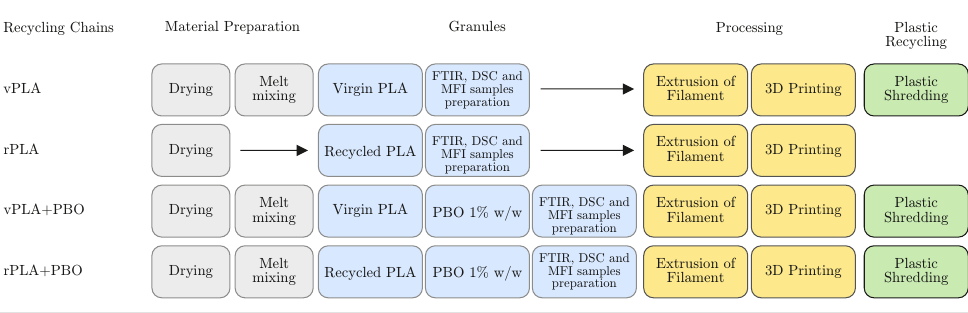
Figure 1. Description of the four different recycling chains and the processes involved (adapted from